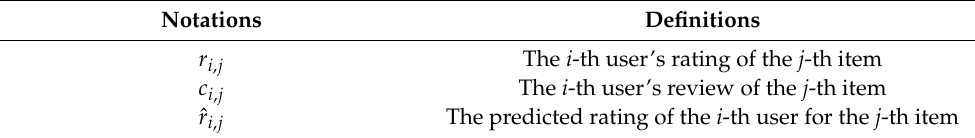
Table 1. Notations and